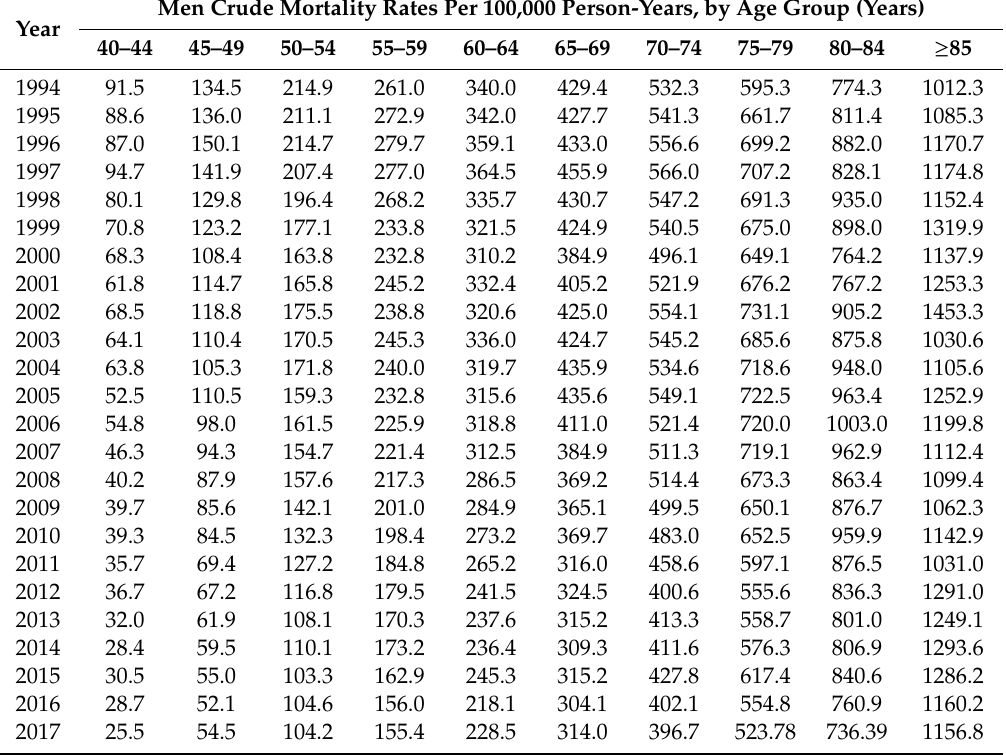
Table A2. Acute myocardial infarction crude mortality rates in men, by age and calendar year.